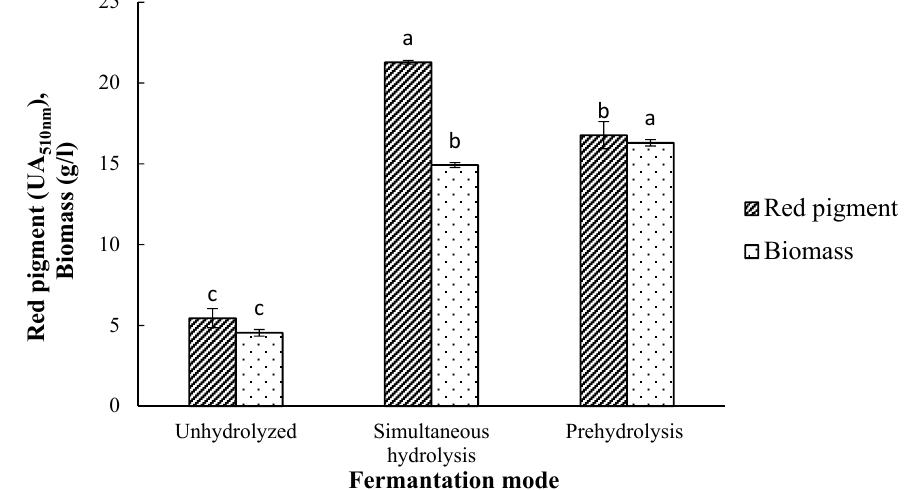
Figure 2. The effect of fermentation mode on the red pigment and biomass production by M. purpureus CMU 001 (Fermentation conditions: 30 °C, 8 days, 200 rpm, pH 6.0, 5 g/L MSG, 50 g/L lactose).